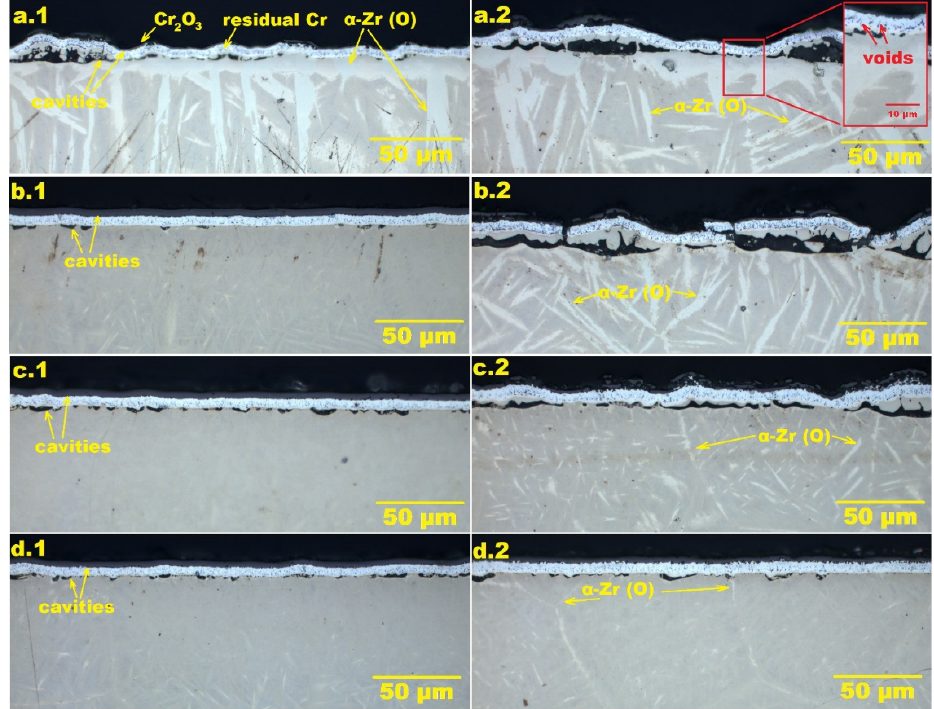
Figure 7. Optical images of the cross-section microstructure of ZrO 2 /Cr-100 ( a.1 , a.2 ), ZrO 2 /Cr-250 ( b.1 , b.2 ), ZrO 2 /Cr-750 ( c.1 , c.2 ), and ZrO 2 /Cr ( d.1 , d.2 ) samples after oxidation in steam at 1200 °C for 1000 and 2000 s, respectively.